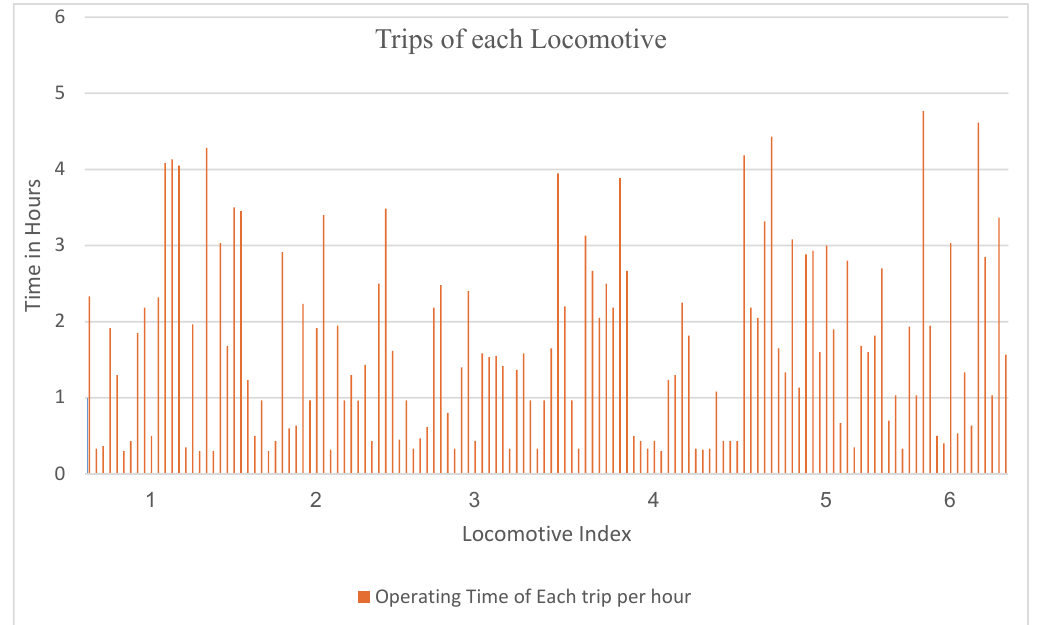
Fig. 15. Trips distribution for the 6 locomotives during three